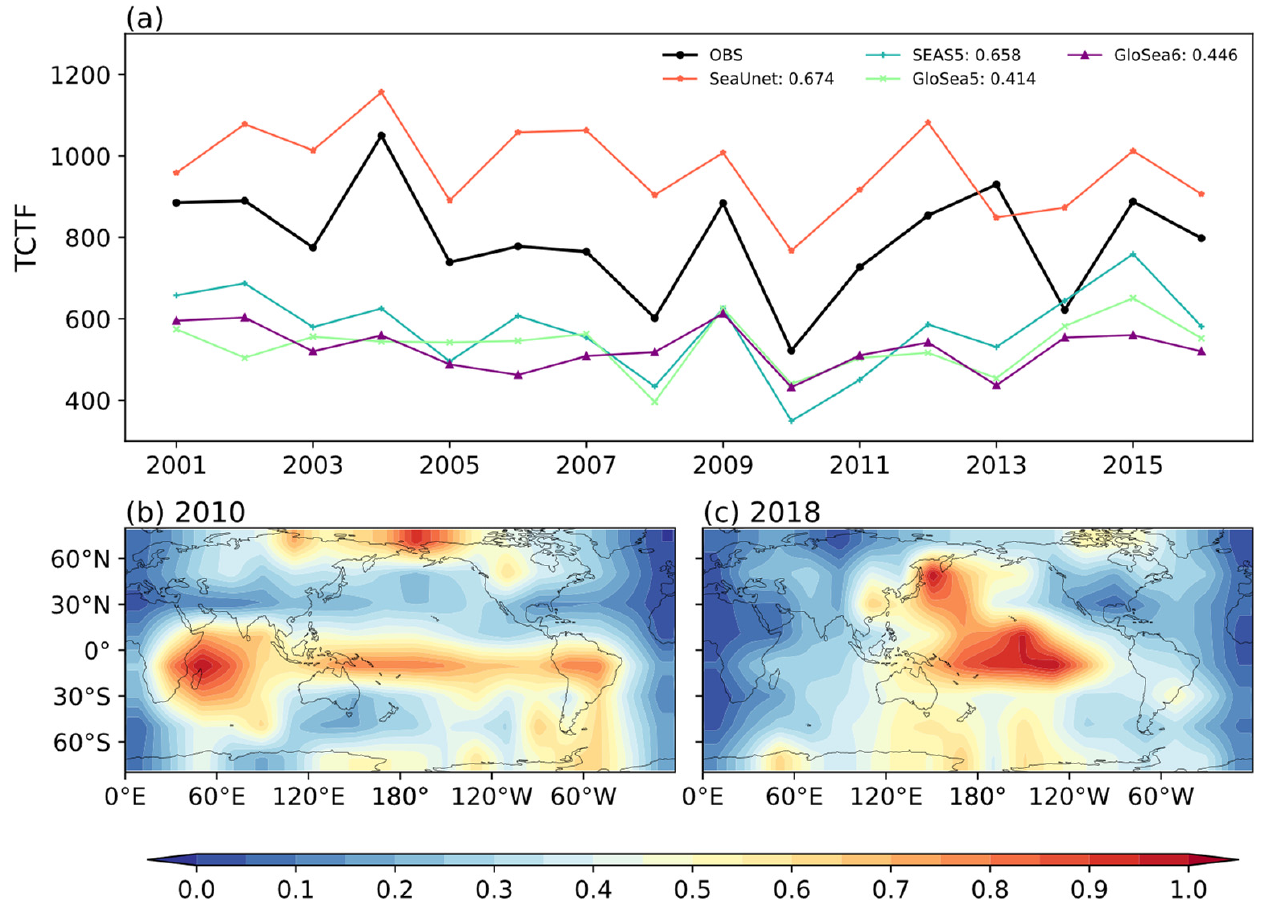
Figure 4. Physical interpretation of SeaUnet model TCTF predictions. ( a ) WNP TCTF predicted by the four models and observations from 2001 to 2016. The number after the colon in the legend represents the correlation coefficient between the predicted and observed values. Note that the lines of the three numerical models (SEAS5, GloSea5, and GloSea6) indicate their ensemble mean (see Table S1 in Supplementary Materials). ( b ) The heat map of 2010. ( c ) The heat map of 2018. The results are predicted by the SeaUnet with boreal-spring subsurface SST of the UK Met Office, using H500 and vertical shear of the u component of wind of the ERA5 data as the predictors.